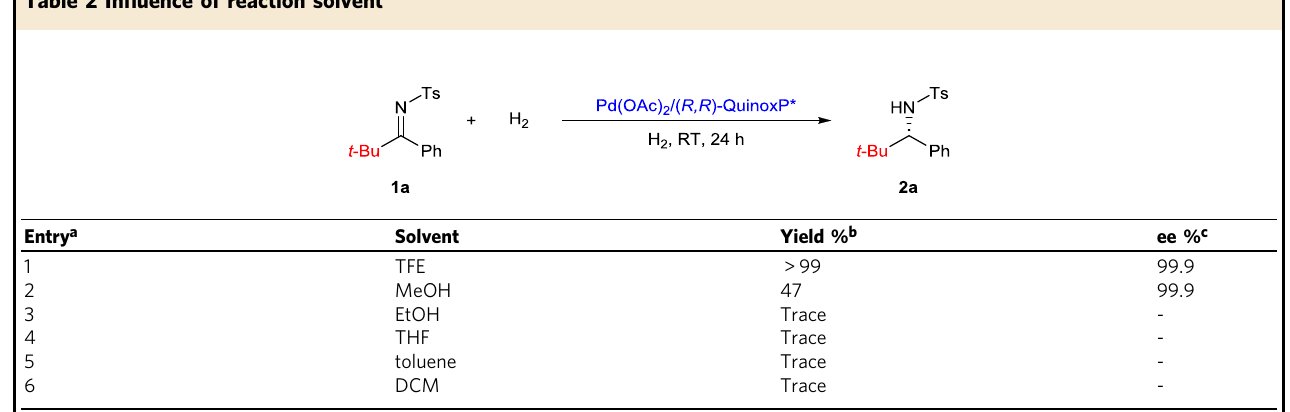
Table 2 In fl uence of reaction